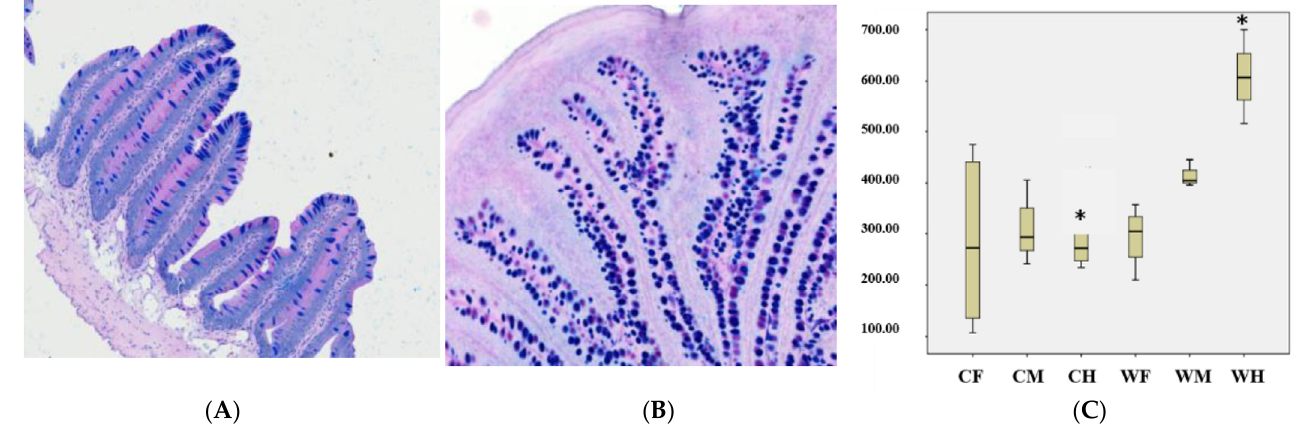
Figure 5. Distribution ( A , B ) and comparison of goblet cells in different intestinal segments ( C ) be- tween cultured ( A ) and wild ( B ) Hemibarbus maculatus. There was no significant difference in the number of goblet cells in foregut and midgut between the wild and the cultured groups, but the wild hindgut was more than the cultured group. (AB-PAS, bar = 50 µ m) Note: n = 30, the data were misrepresented by average ± standard deviation, * indicates that the data were different from those of cultured (wild) ( p < 0.05).